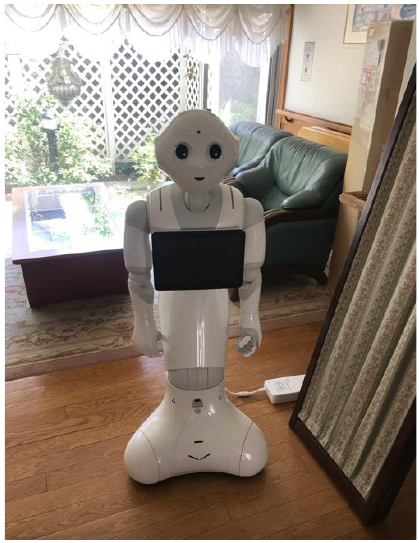
Figure 1. – Picture of Pepper in the Japanese nursing home (© Anne